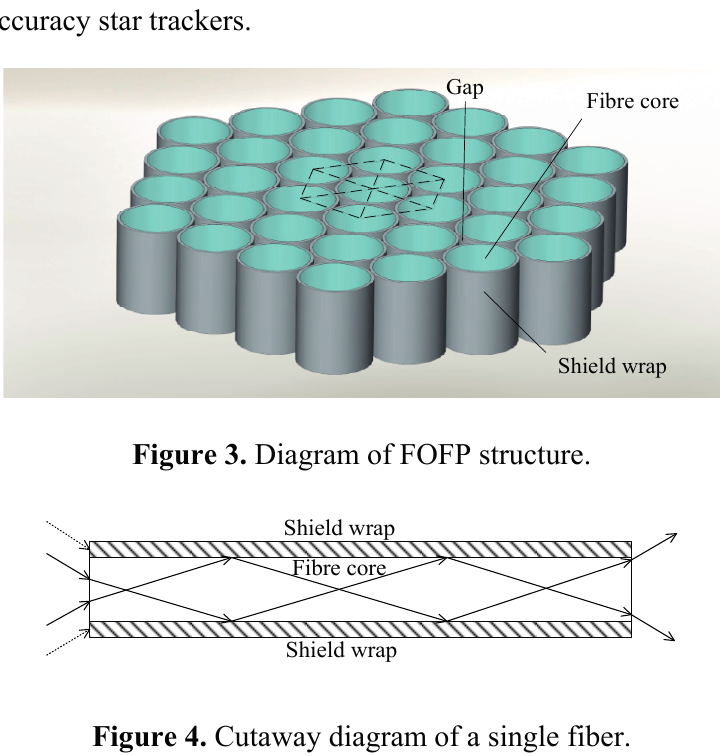
Figure 4. Cutaway diagram of a single